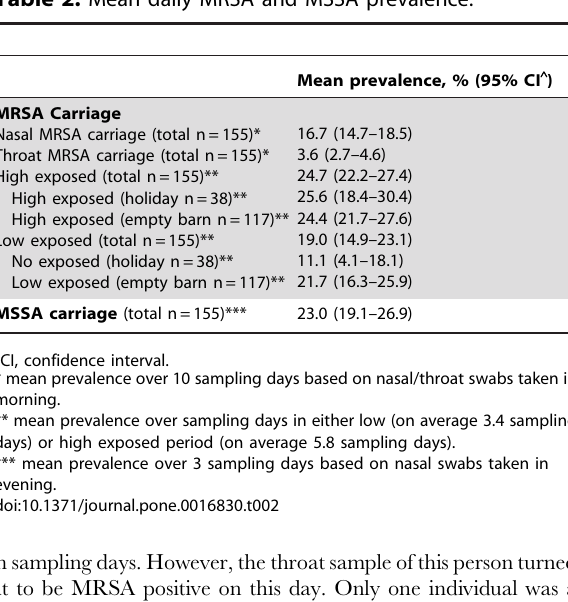
Table 2. Mean daily MRSA and MSSA prevalence.